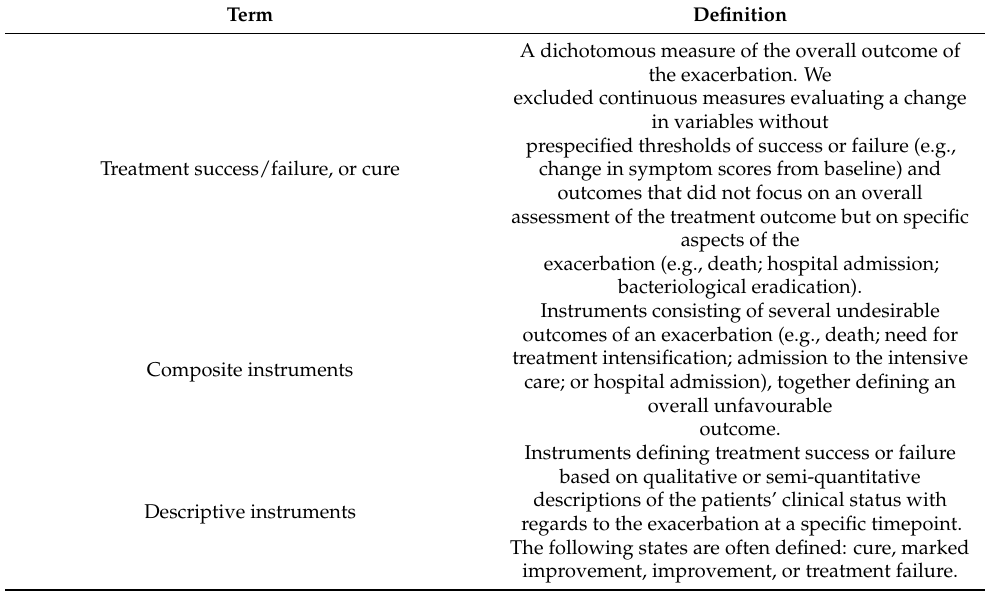
Table 1. Definitions of treatment success/failure and of the measurement instruments’